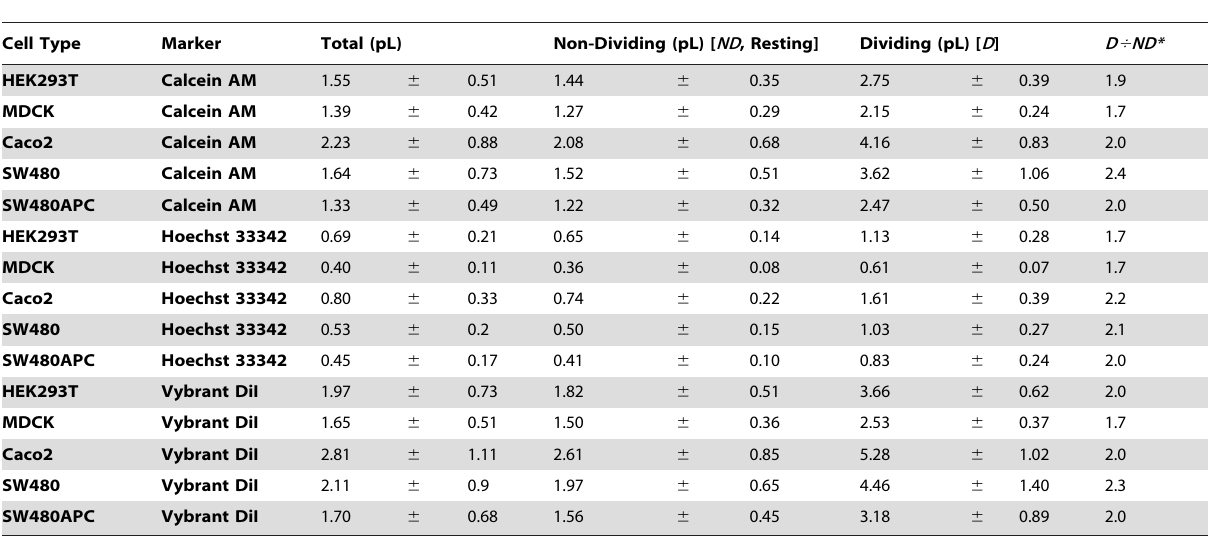
Table 2. Summary for fluorescence marked volumes for all five cell types.